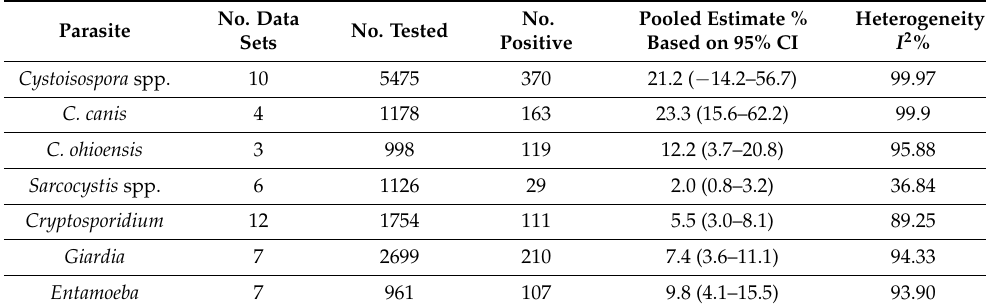
Table 10. Pooled prevalences estimated for protozoa detected in feces and/or intestinal scrapings of dogs from